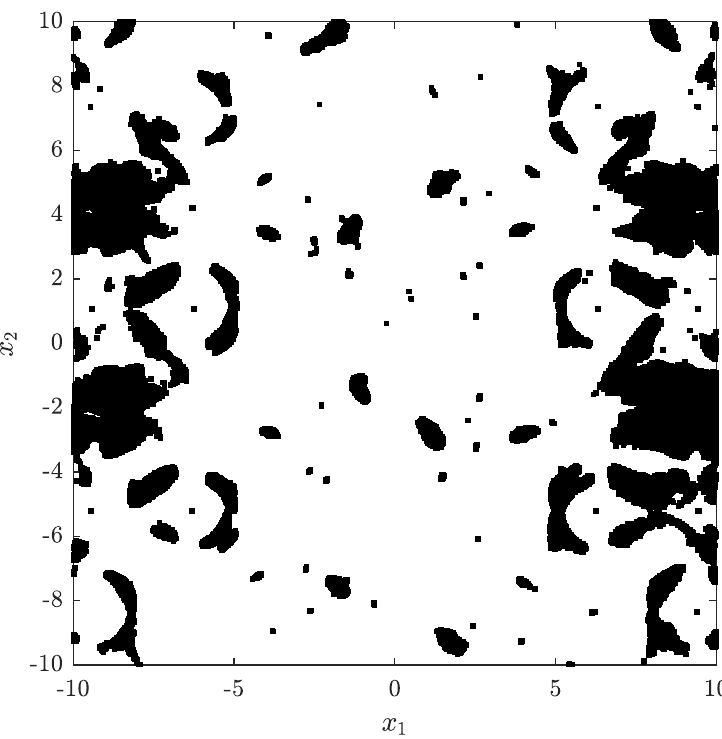
Figure 3. The black areas indicate the states for which observability on D x (29) could not be proven after 691,000 iterations for the nonlinear system